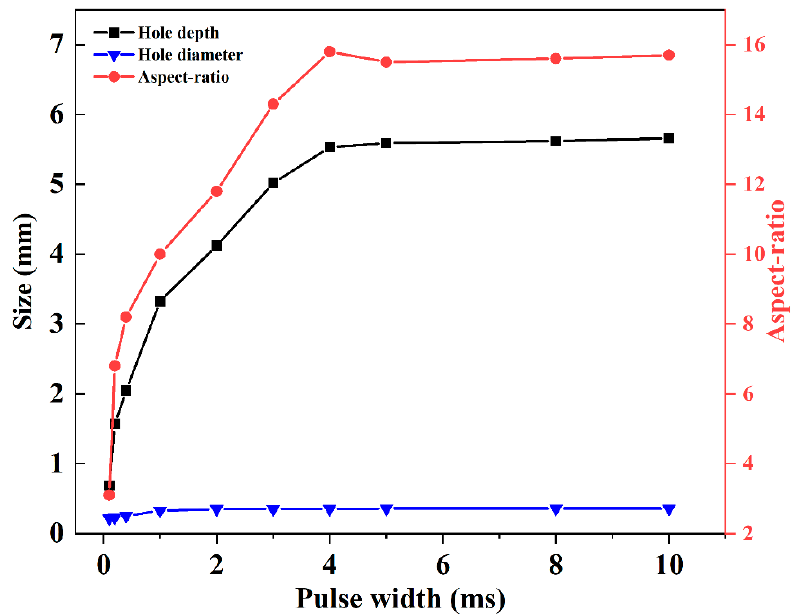
Figure 7. Hole depth, hole diameter, and aspect ratio under different pulse widths at the peak power of 500 W for single-pulse laser drilling.